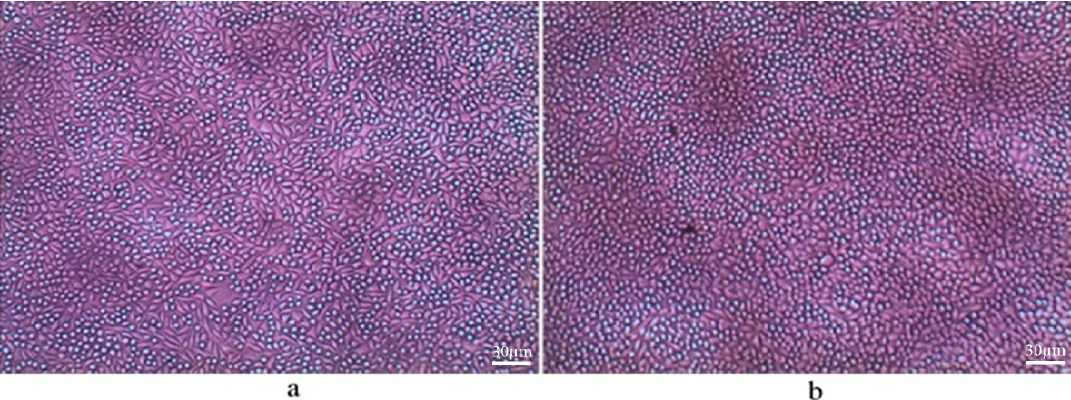
Figure 2. Day 3 cell culture of PEEK/20 wt% HA/ 0.5 wt% CF: ( a ) 75% porosity and ( b ) 85% porosity, concentration 1:4.